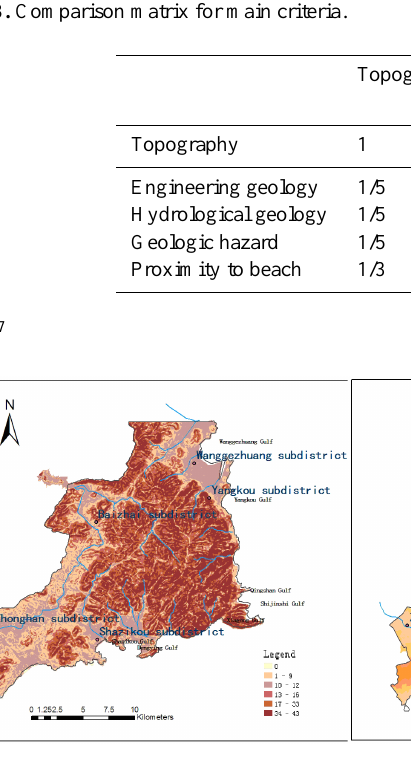
Fig. 4. Landform maps. (a) : slope map; (b) : elevation map; (c) : relief